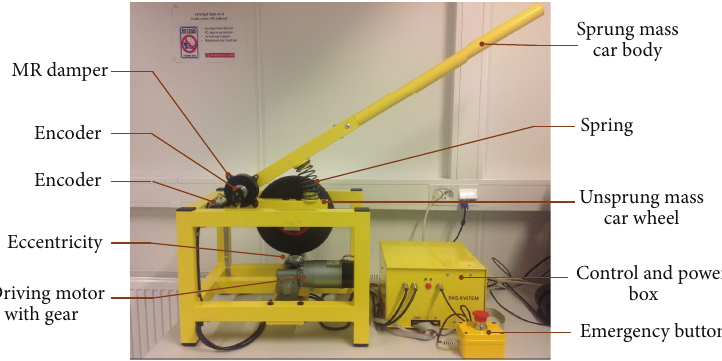
Figure 1: Semiactive suspension (SAS) system.